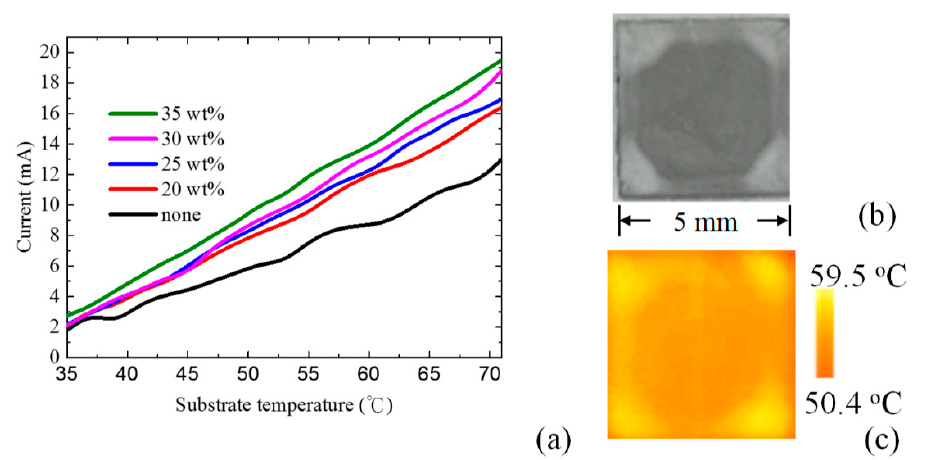
Figure 6. ( a ) Enhanced output current of thermoelectric generator (TEG) chip as a function of substrate temperature. Black line is the output current of the bare TEG chip. Red, blue, pink, and green lines represent the TEG stacked with the 15 wt%, 20 wt%, 25 wt%, and 35 wt% SiO 2 –PMMA composite films, respectively; ( b ) Photograph of the SiO 2 –PMMA composite film; ( c ) Temperature distribution of SiO 2 –PMMA composite film on a heated substrate.